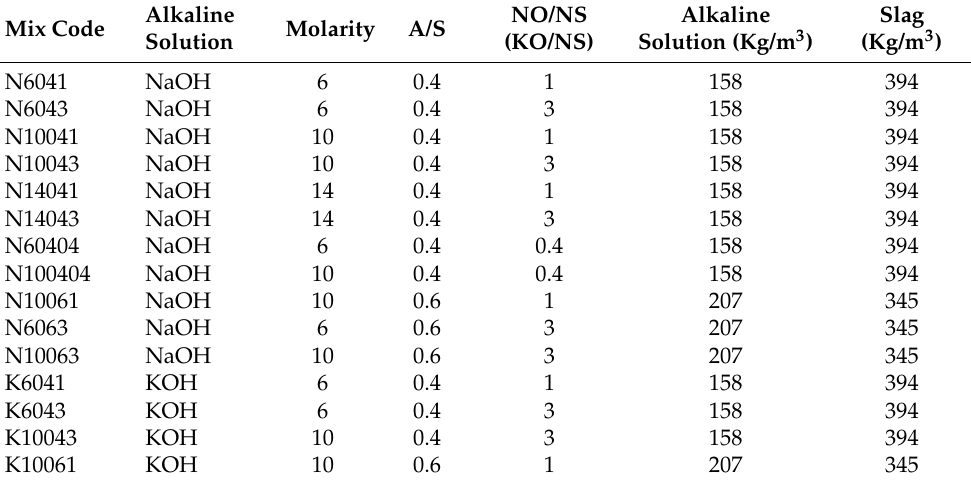
Table 3. AASC mix designs (A/S: the weight ratio of alkaline solutions to slag, NO/NS and KO/NS: the weight ratio of NaOH (or KOH) to Na 2 SiO 3